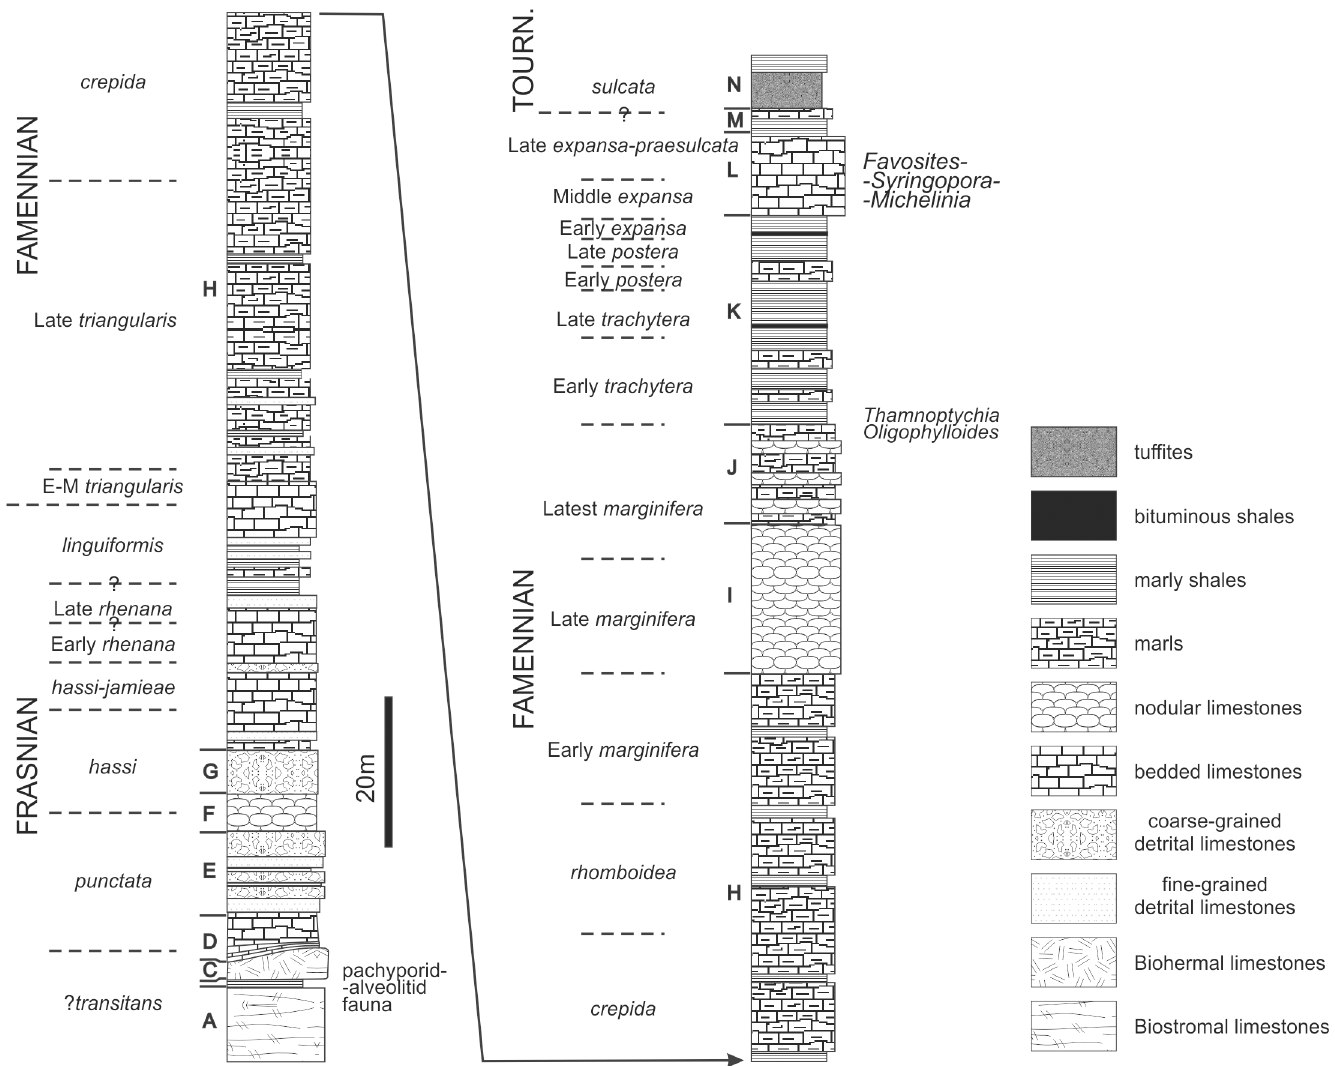
Fig 2. Simplified lithostratigraphic column of the Devonian in Kowala. Based on lithostratigraphic columns and data from various sources [3, 12, 26, 32],